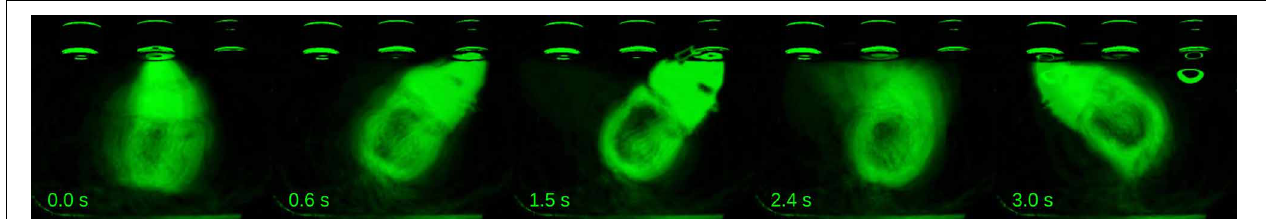
FIGURE 2 | Behavior displayed during stimulus interval is highly reproducible. A series of video frames taken from a representative session of rat Fernando at specific time points within trials were